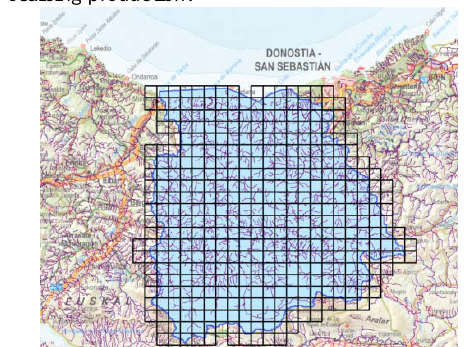
Figure 5. Example DTM files selection (in black) per one working unit (in